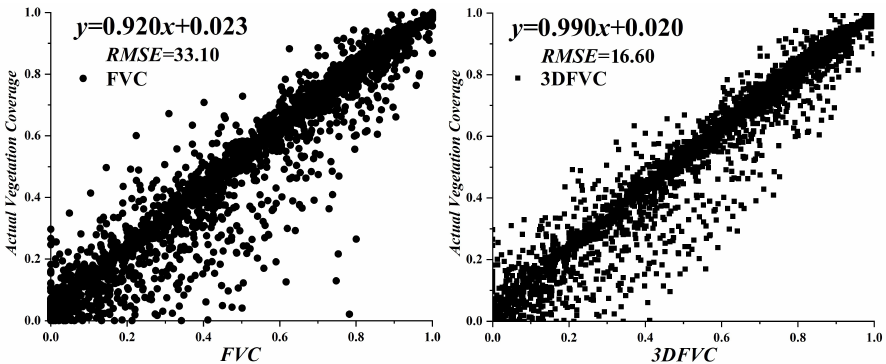
Figure 7. Accuracy comparison between FVC and